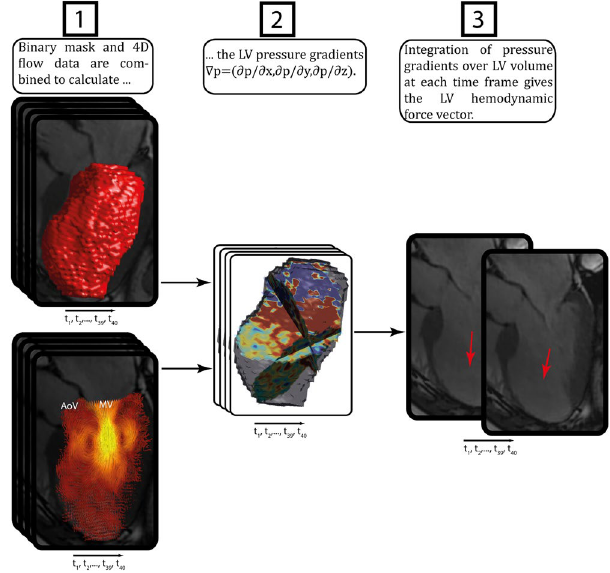
Figure 3. Schematic overview of the analysis method: (1) a binary mask is generated from the segmentation of the bSSFP short axis images and superimposed on magnitude data from the 4D flow scan, and adjusted in order to avoid possible mismatch problems between bSSFP-images and flow data, (2) the LV pressure gradients ∇ p = ( ∂ p/ ∂ x, ∂ p/ ∂ y, ∂ p/ ∂ z) are calculated by using the velocity data and binary mask, (3) integration of pressure gradients over the LV volume at each time frame gives the LV hemodynamic force